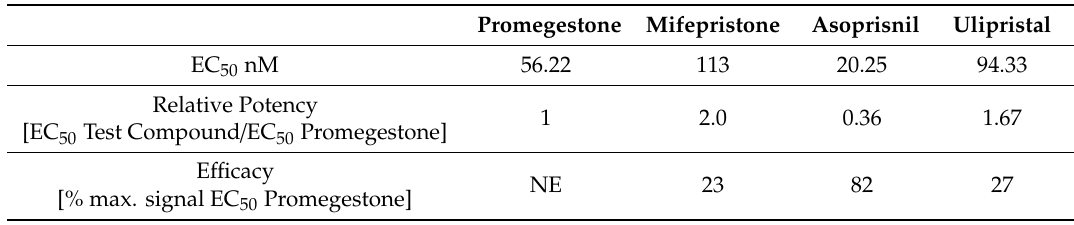
Figure 3. The tested compounds induced cyclin D1 expression in T47D cells during treatment for 24 Table 2. Cyclin D1 expression induced by SPRMs in T47D cells (EC 50 , relative potency and e ffi cacy